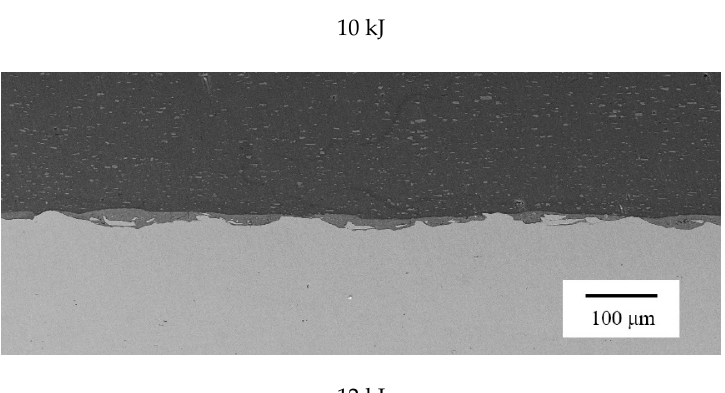
Figure 10. Interface morphologies with 6 kJ, 10 kJ, and 12 kJ input energies.